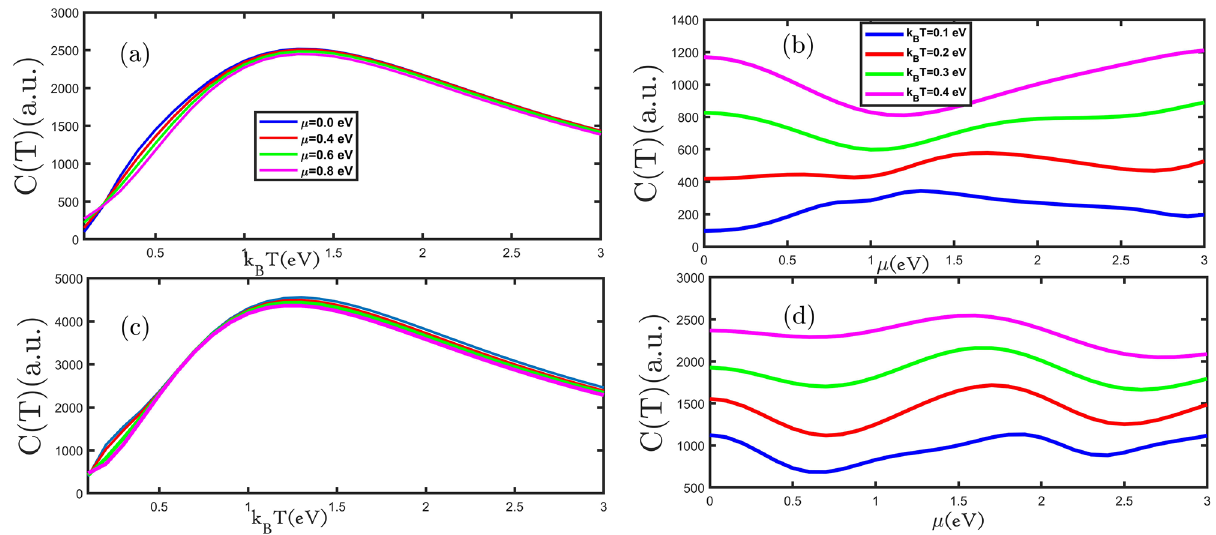
Figure 4. ( a – d ) the electronic heat capacity as a function of the temperature (electron doping) for the planar and buckled silicene monolayer in the presence of different electron doping (temperatures),